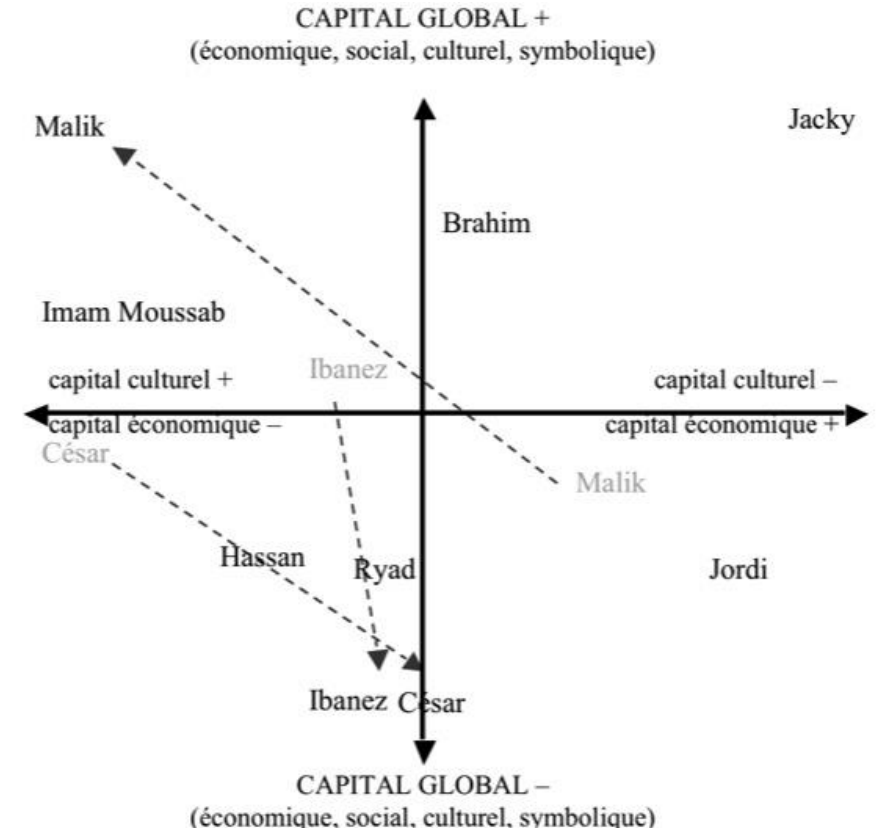
Figure 3 Espace final des positions sociales des personnages d’ Un